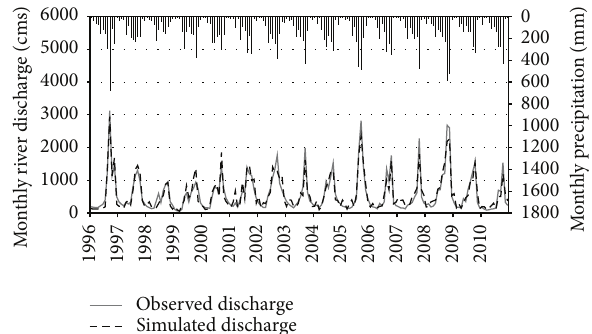
Figure 3: Monthly time series comparison of simulated versus observed river discharge at Yen Thuong Station with reference to monthly precipitation during the 15-year validation period (1996–